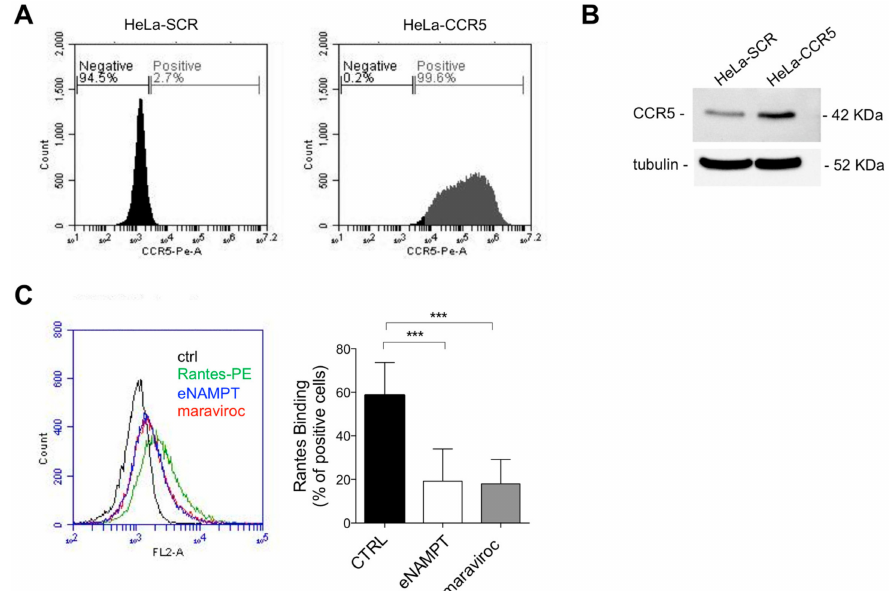
Figure 1. Extracellular nicotinamide phosphoribosyltrasferase (eNAMPT) binds to C-C chemokine receptor type 5 (CCR5) in HeLa cancer cells. ( A ) Representative flow cytometry analysis of CCR5 expression in HeLa-SCR and HeLa-CCR5 cells, using Rat anti-mouse CCR5 antibody. ( B ) Western blot analysis of CCR5 expression in HeLa-SCR and HeLa-CCR5 cells. The CCR5 antibody recognizes both human endogenous CCR5 and murine exogenous CCR5. ( C ) Representative FACS analysis and calculated percentage of positive cells of Rantes-PE (16 nM) binding on HeLa-CCR5 cells incubated in the presence or absence of eNAMPT (2.25 µ M) or maraviroc (10 µ M). Mean ± S.E.M. of five separate experiments; *** p <